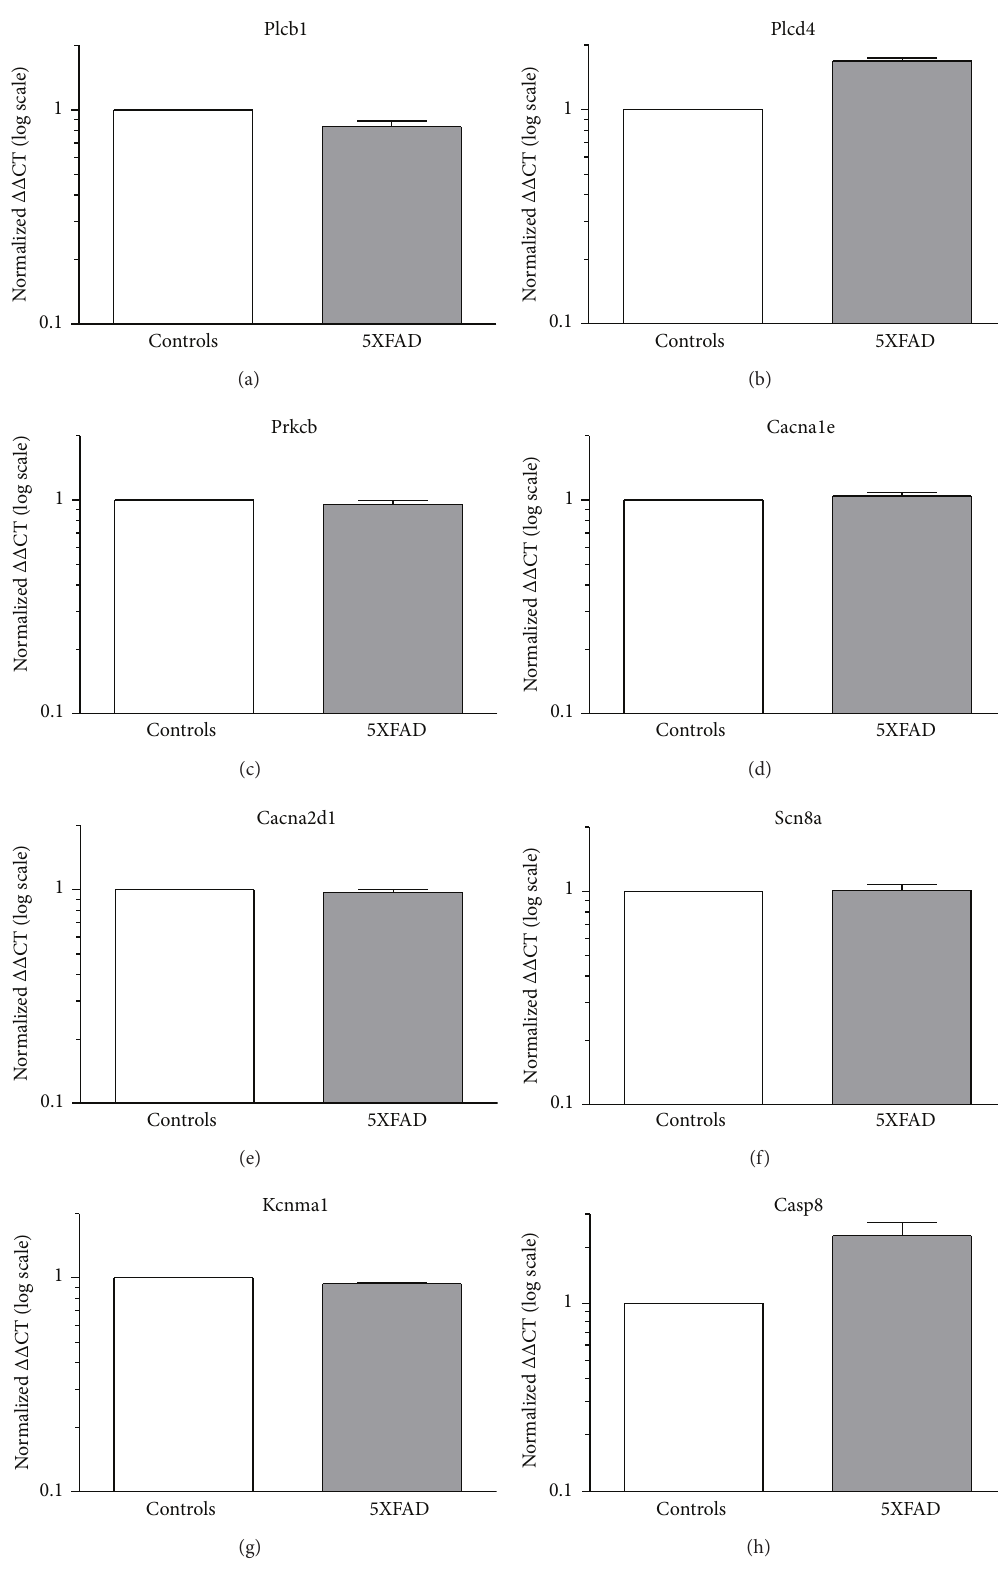
Figure 3: Gene transcription profiles in 5XFAD mice. RNA extracted from the hippocampus of control and 5XFAD mice was used for microarray analysis. A selected number of candidates which exhibited altered expression profile in microarray analysis were further validated using quantitative real-time PCR (qPCR). Normalized ΔΔ CT (log scale) for Cacna2d1, Kcnma1, Ca and Casp8 is depicted. Note that a minor decrease in Plcb1 transcript levels turned out to exist, but a clear increase in Plcd4 in 5XFAD